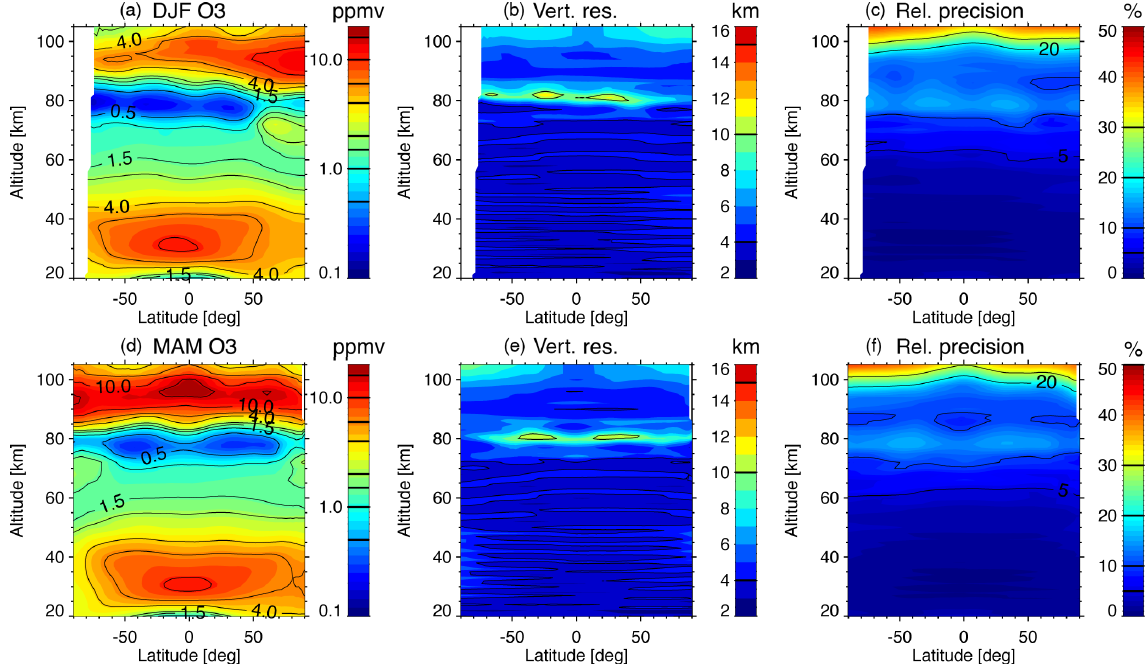
Figure 4. As Fig. 3 but for nighttime